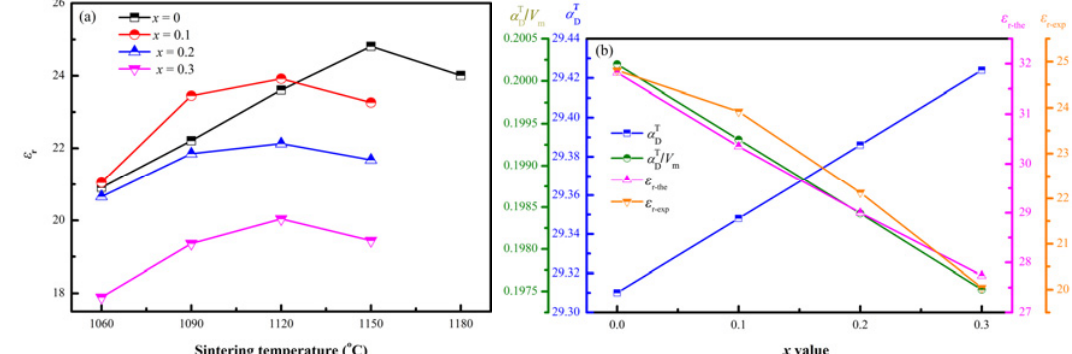
Fig. 8 (a) Variations of ε r for LZTNN x ceramics sintered at various temperatures and (b) variations of and ε r-the with x